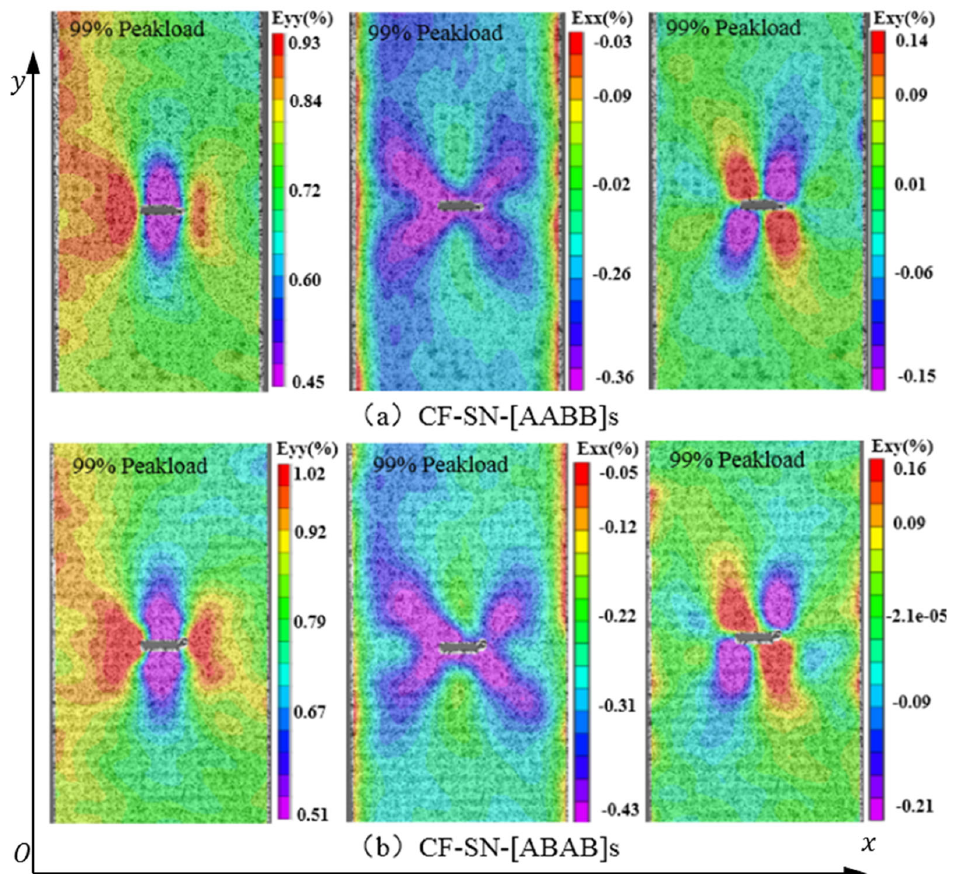
Figure 12. Strain field distribution of straight-notched specimens with different layer sequences under a 99% ultimate tensile load; the strain concentrated in the areas around the tips of the straight notch, and the contour values of shear strain were distributed alternately in positive and negative areas ( a ) CF ‐ SN ‐ [AABB]s, ( b ) CF ‐ SN ‐ [ABAB]s.